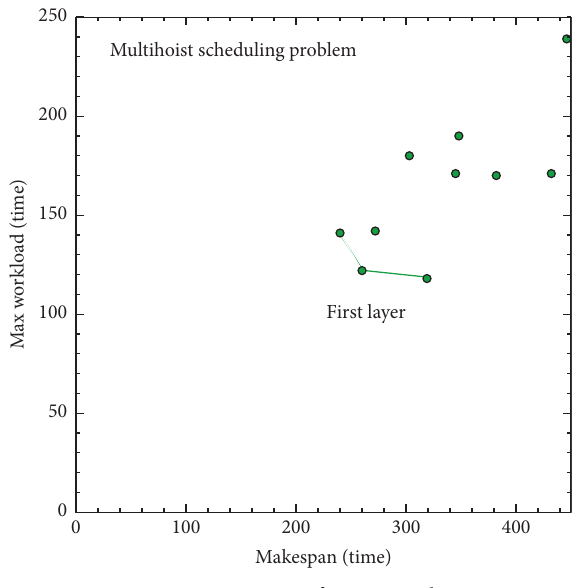
Figure 4: A Pareto-front